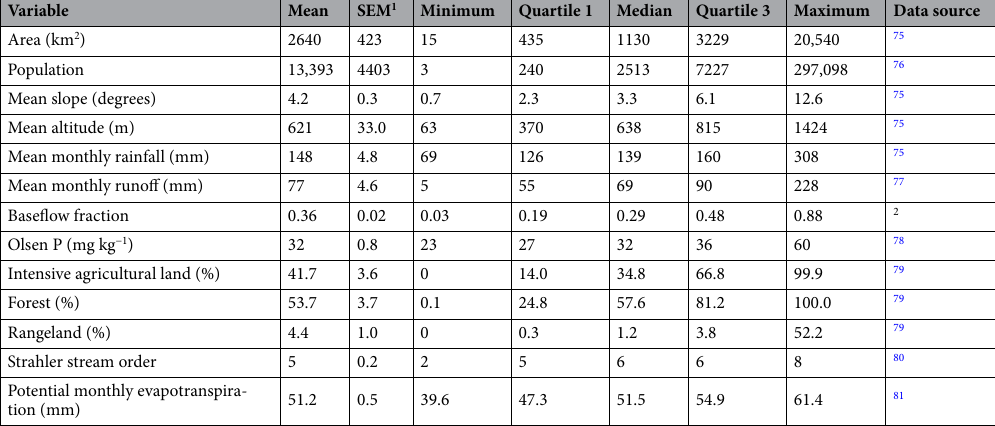
Table 1. Summary statistics for biophysical parameters describing the 77 catchments of the National River Water Quality Network. Geology was added as a categorical variable assigned to either sedimentary, metamorphic or volcanic 74 . 1 SEM standard error of the mean. 2 Calculated according to the method of Pelletier and Andréassian 55